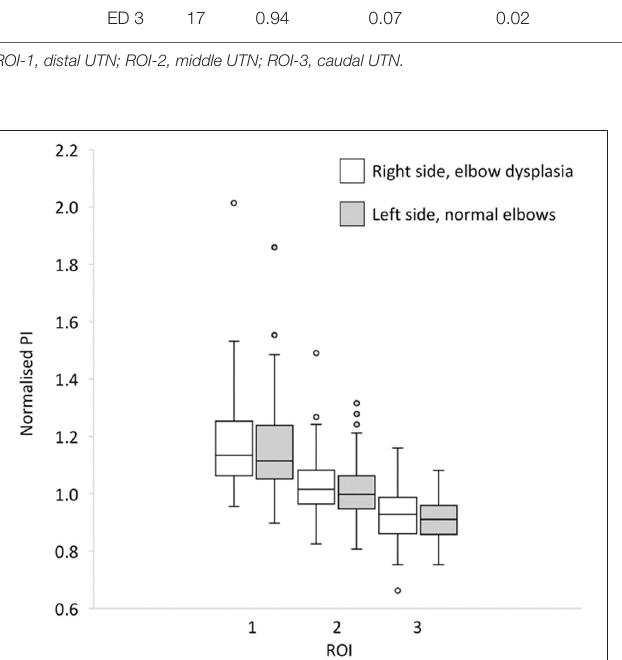
indicated that UTN sclerosis may even be reduced in elbow joints affected only with UAP (14).